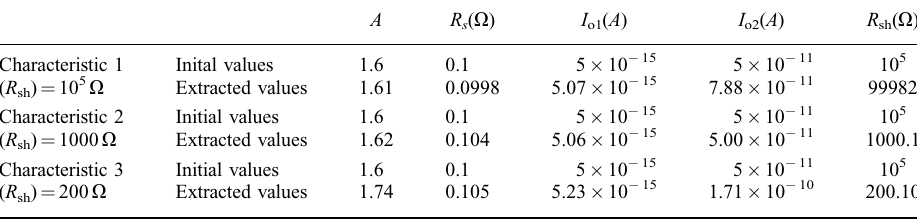
TABLE I Estimated Parameter Values Extracted with our Method from a Theoretical Characteristic and for Three Shunt Resistance R sh Values. A R s ( O ) I o1 ( A ) I o2 ( A ) R sh ( O